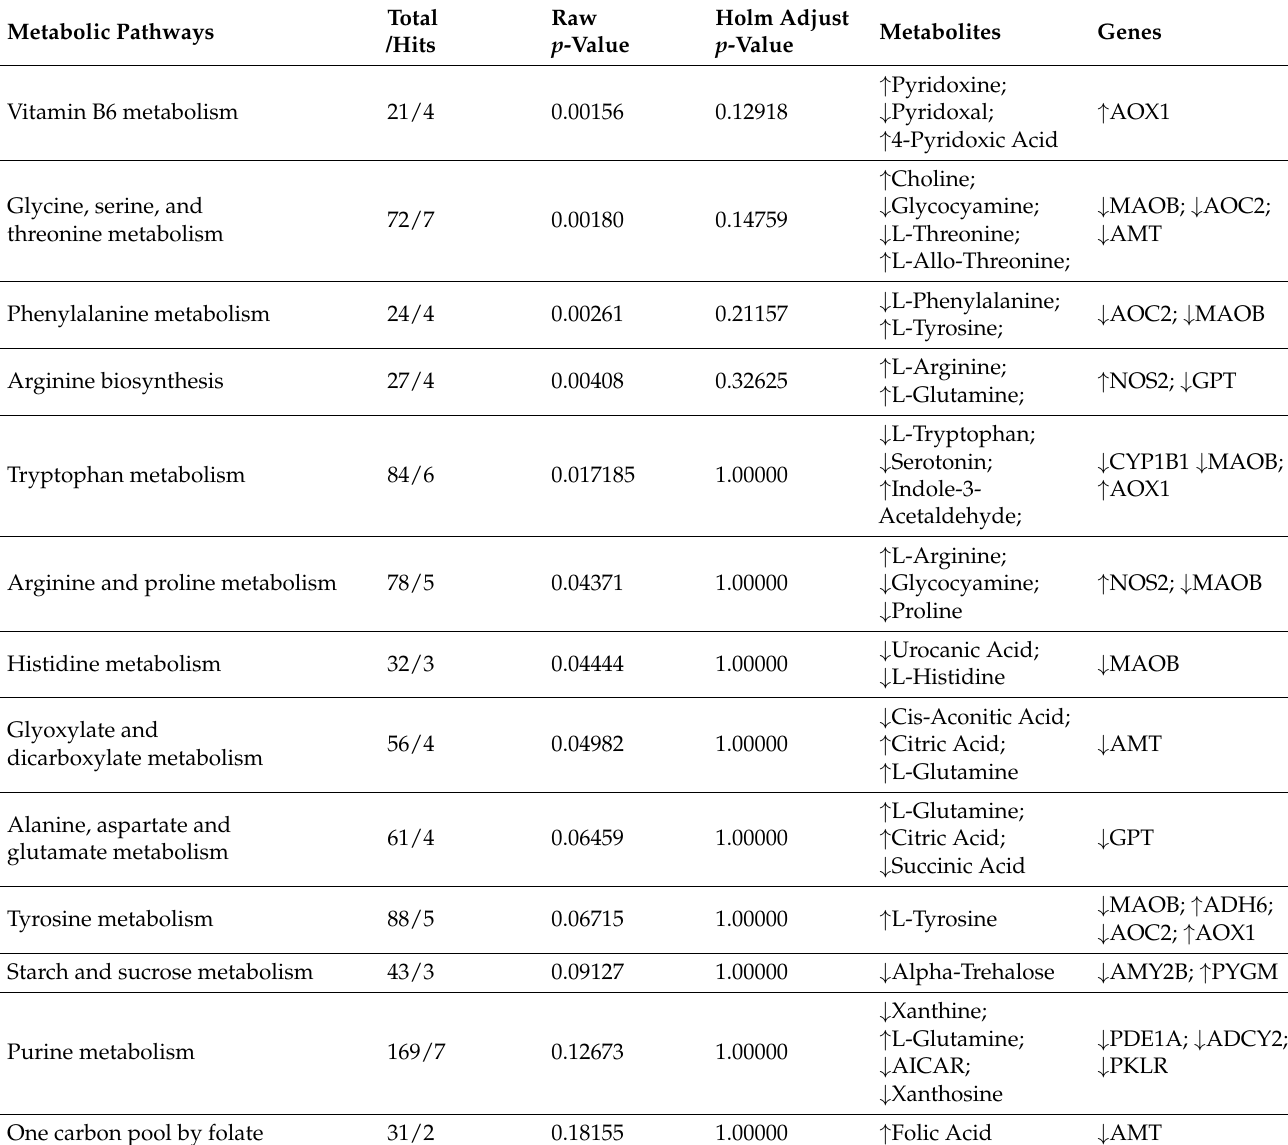
Table 3. Important functional pathways, metabolites, and genes. Important metabolic pathways from an integrated analysis of metabolites and genes are presented. Complete statistical detailing of the pathways and a list of functional hits along with their regulation statuses are